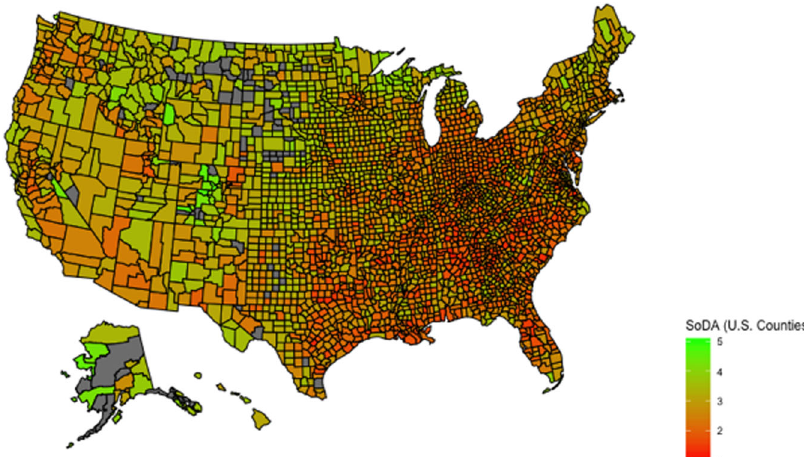
Fig. 4 Top 25 most substantial features model results heat map by United States county. Authors ’ analysis of authors ’ model based on data from the unacast social distancing dataset between from March 16, 2020 ( fi rst day of the national stray at home order) to April 24, 2020 ( fi rst day a state relaxed the social distancing guidelines), CDC, and CNN news reports. States that are grey did not have suf fi cient amount of cellphone data to be